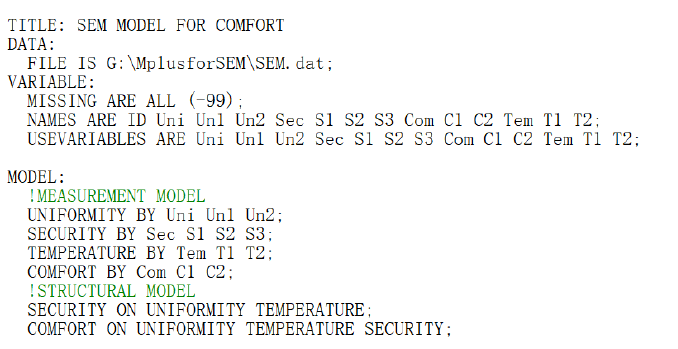
Table 3. The results of the hypothetical comfort evaluation model.